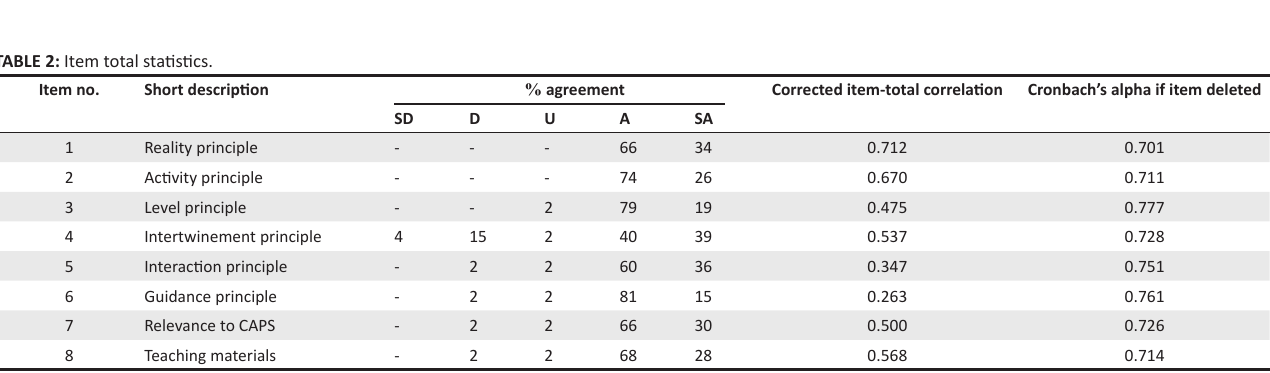
FIGURE 1: Feedback questionnaire.